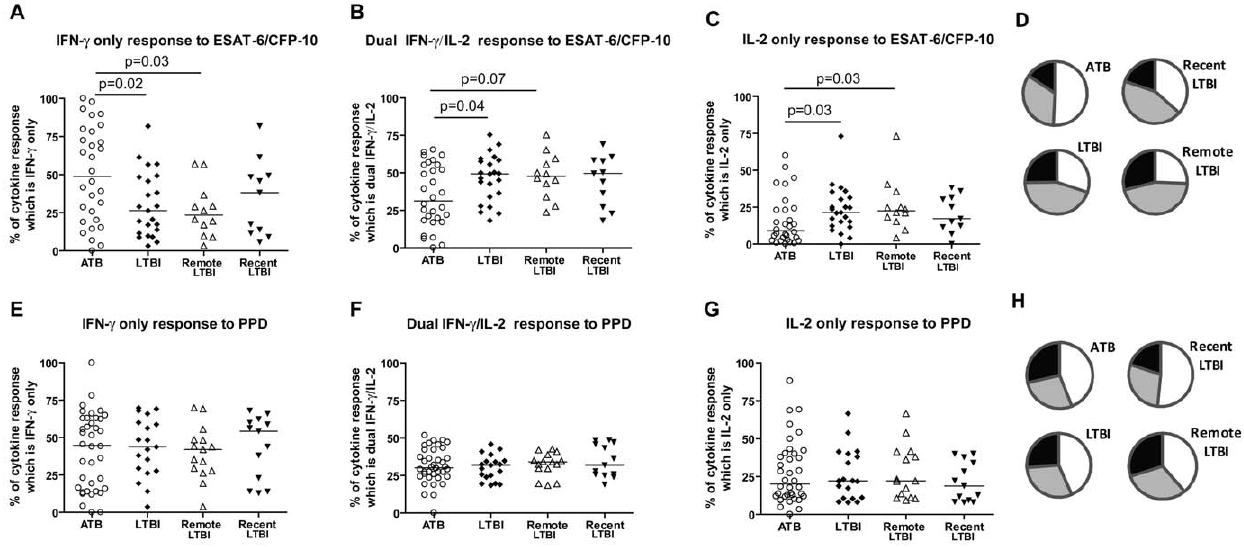
Figure 6. Cytokine responses to ESAT-6/CFP-10 and PPD in untreated active TB patients and persons with latent TB infection (LTBI). PBMC from 32 untreated patients with Active TB (ATB, circles) and 26 persons with LTBI (diamonds) were stimulated with ESAT-6/CFP-10 (A–D) or PPD (E–H) and the number of IFN- c -only secreting cells (A,E) dual IFN- c /IL-2 –secreting cells (B,F) and IL-2-only secreting cells (C,G) were enumerated by fluorescence-immunospot. LTBI data was also subdivided into persons with recent exposure (black triangles, n=13) and those with remote exposure to an infectious TB case (hollow triangles, n=13). Data are expressed for all responding patients as the percentage of the total number of cytokine- secreting cells detected which were IFN- c -only, IL-2-only or dual IFN- c /IL-2-secreting cells. P values are stated for comparisons of ATB with all LTBI and remote LTBI only. There was no statistically significant difference between the proportions of IFN- c -only, IL-2-only or dual IFN- c /IL-2 –secreting ESAT- 6/CFP-10-specific cells in ATB and recent LTBI (p=0.15, p=0.16, p=0.18, respectively). There was no statistically significant difference between the proportions of any PPD-specific cytokine-secreting cells (data not shown). Mean proportions of ESAT-6/CFP-10–specific and PPD-specific cytokine- secreting cells for each patient group are depicted as pie charts in figures D and H respectively (where white= IFN- c only, Grey = IFN- c /IL-2 and black = IL-2 only-secreting cells).